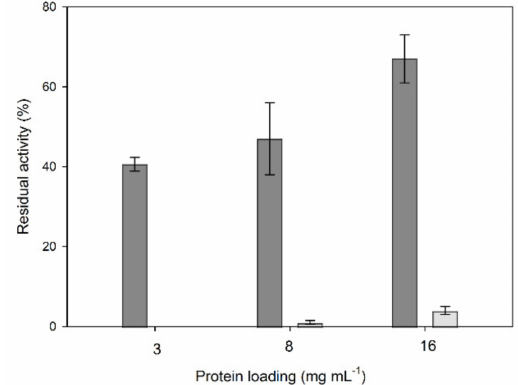
Figure 1. E ff ect of protein loading on the residual activity of crude laccase crosslinked enzyme aggregates (CLEAs). Dark grey bars: CLEAs, and light grey bars: residual free